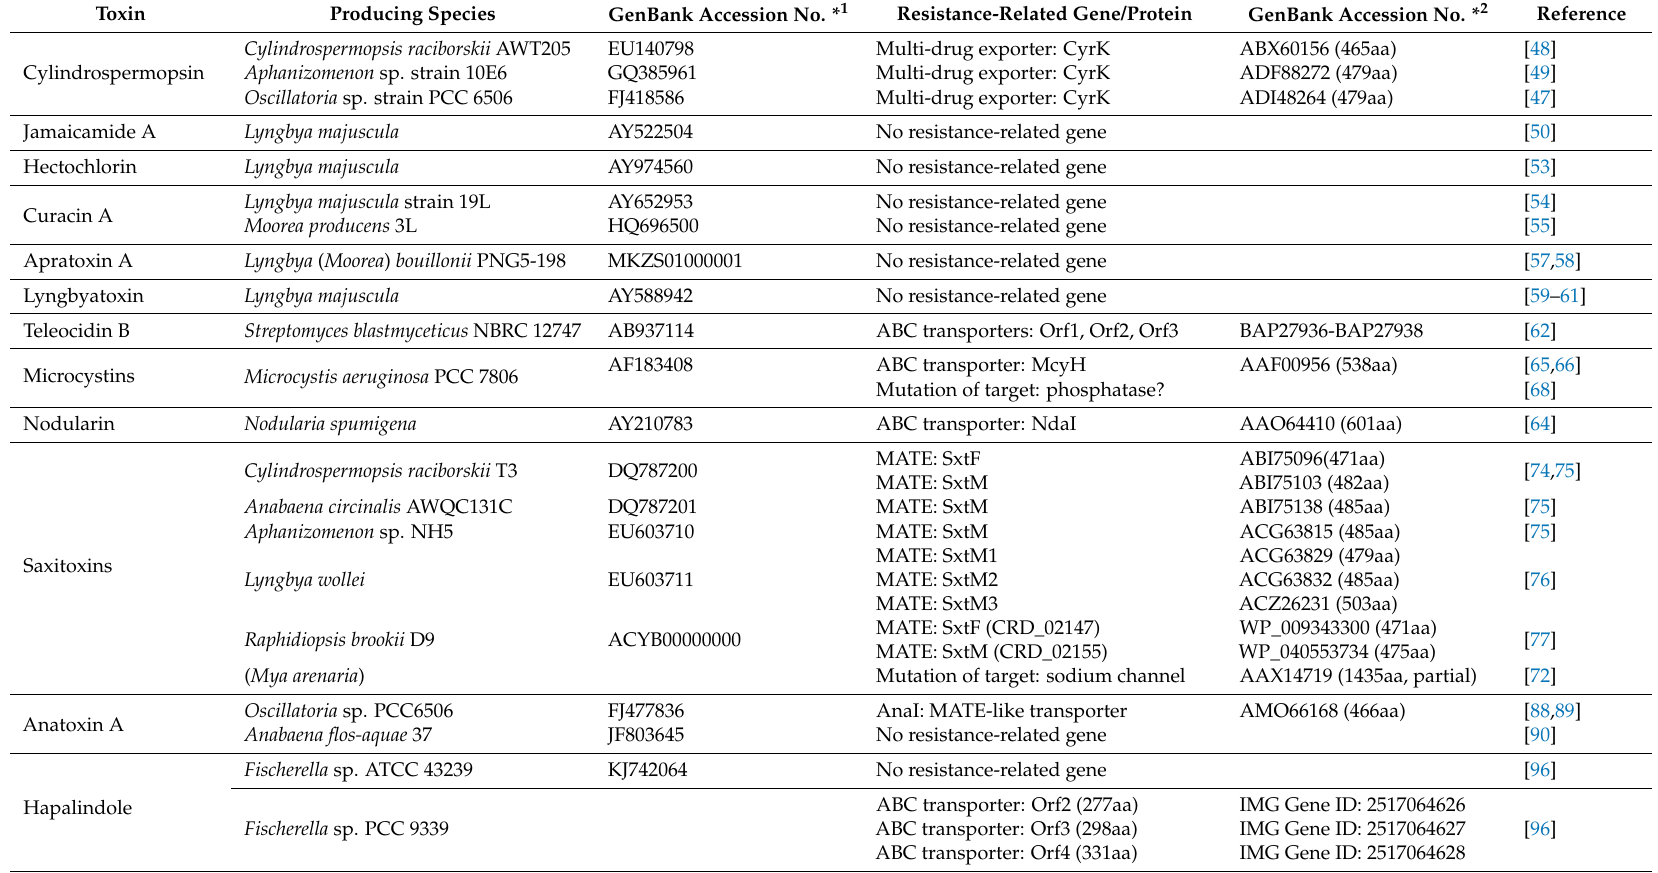
Table 1. Resistance-related genes in biosynthetic gene clusters of phycotoxins and related compounds.